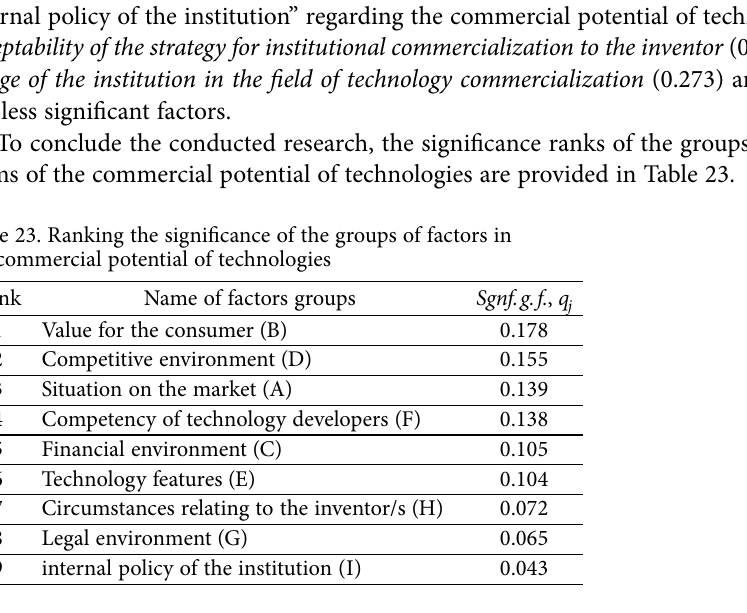
Table 23. Ranking the significance of the groups of factors in the commercial potential of technologies Rank Name of factors groups Sgnf. g. f. , q Value for the consumer (B) 0.178